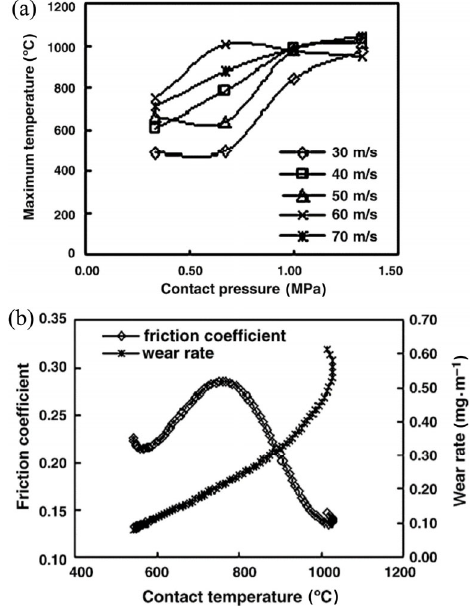
Fig. 13 Significance of contact temperature: (a) variation in maximum contact temperature with increment in contact pressure at discrete sliding speeds; (b)variation in CoF and wear rate with increment in contact temperature. Reproduced with permission from Ref. [114]. Copyright Elsevier, 2006.